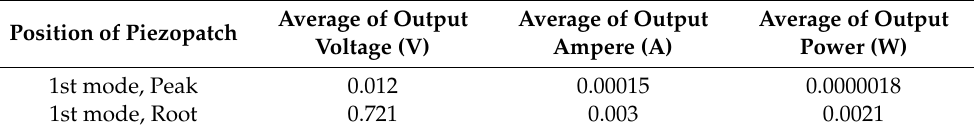
Table 2. SESS (single elastic steel sheet) power generated at the root and the peak of the first